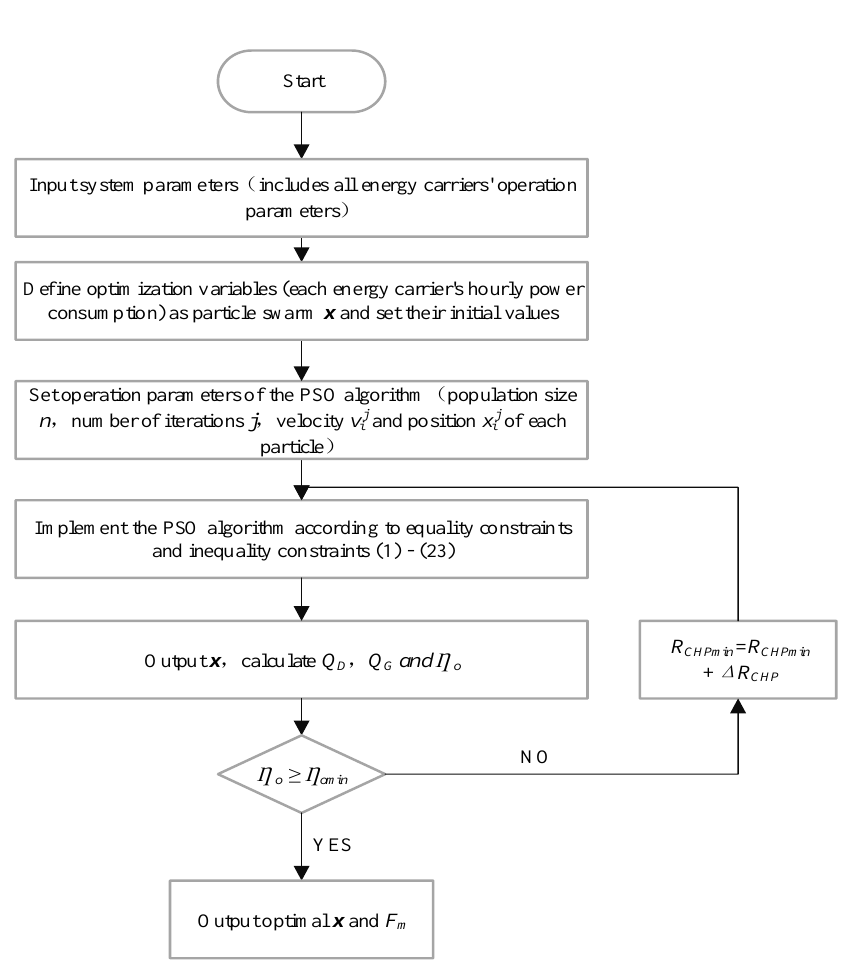
Figure 3. A flow diagram of the proposed particle swarm optimization algorithm.